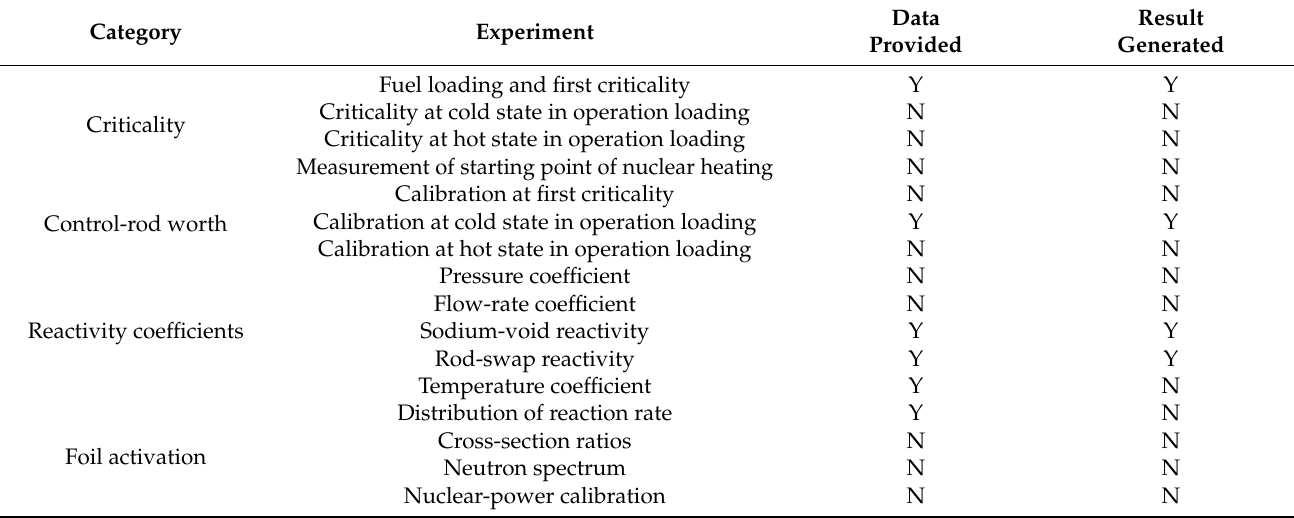
Table 2. List of Start-up